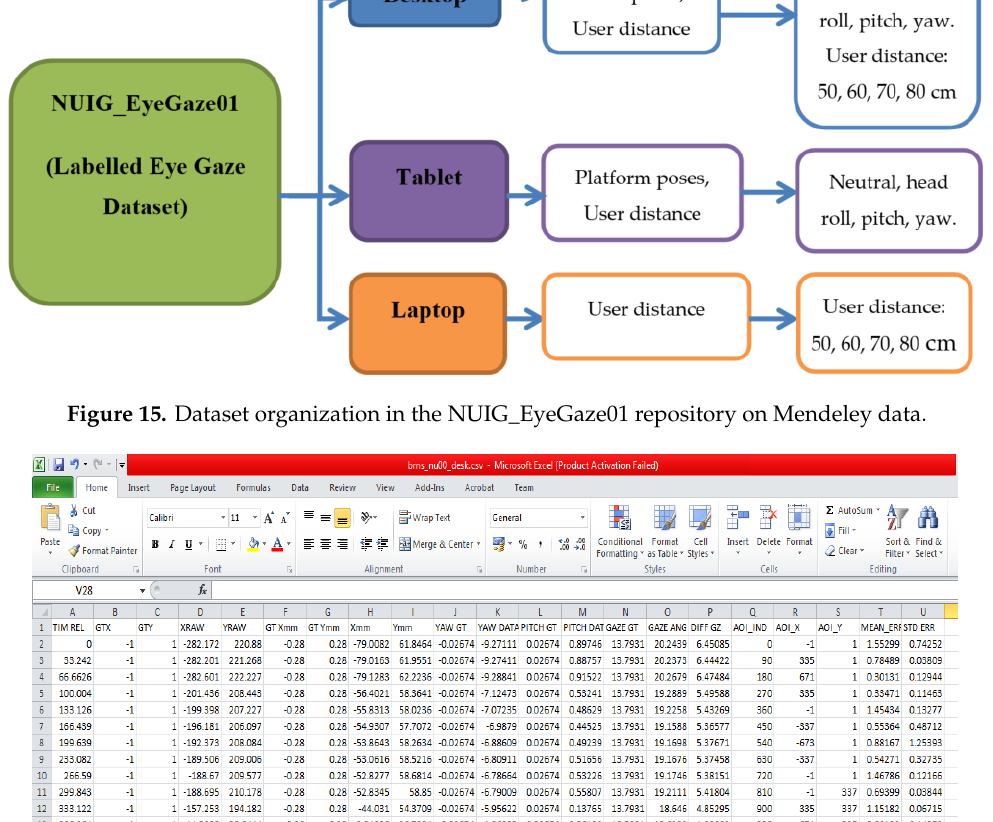
Figure 16. A screenshot of the data format in each comma separated values (CSV) file in the gaze dataset.